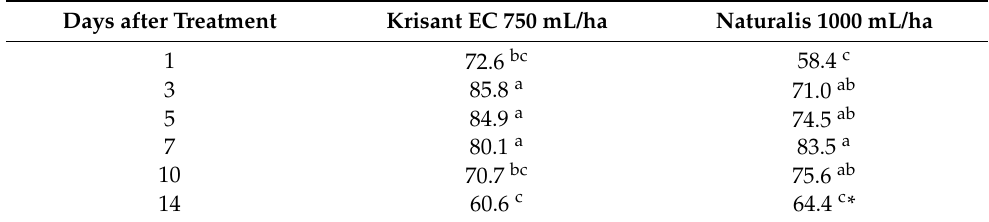
Table 2. Effectiveness (%) of plant protection products against black bean aphid ( Aphis fabae Scop.) in organic bean fields.